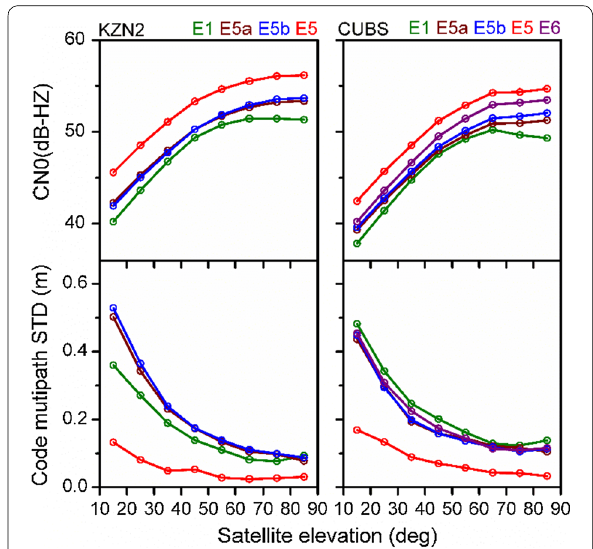
Fig. 13 C/N0 and Code multipath effect with different frequencies based on all Galileo observations for stations KZN2 ( left ) and CUBS ( right ) during DOY 200–206 of